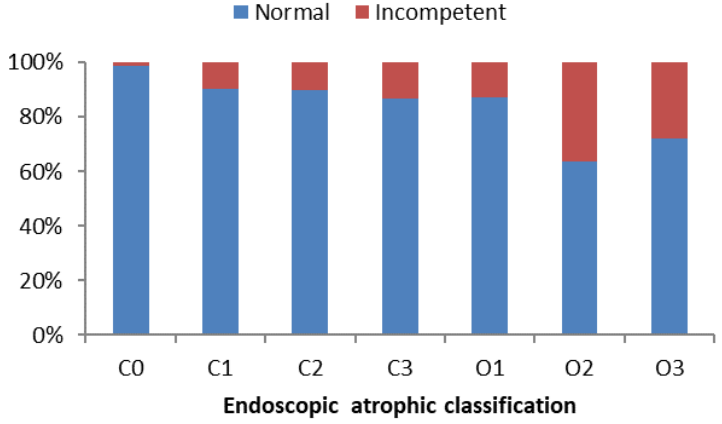
Figure 2. Endoscopic atrophic classification and competence of pylorus. The incidence of pyloric incompetence increased with the severity of atrophic gastritis. Particularly, the incidence of incompetent pylori was significantly higher in open-type atrophic gastritis (8.2% vs. 20.9%, p < 0.001). Table 3. Multivariate analysis of factors according to the competency of the pylorus.